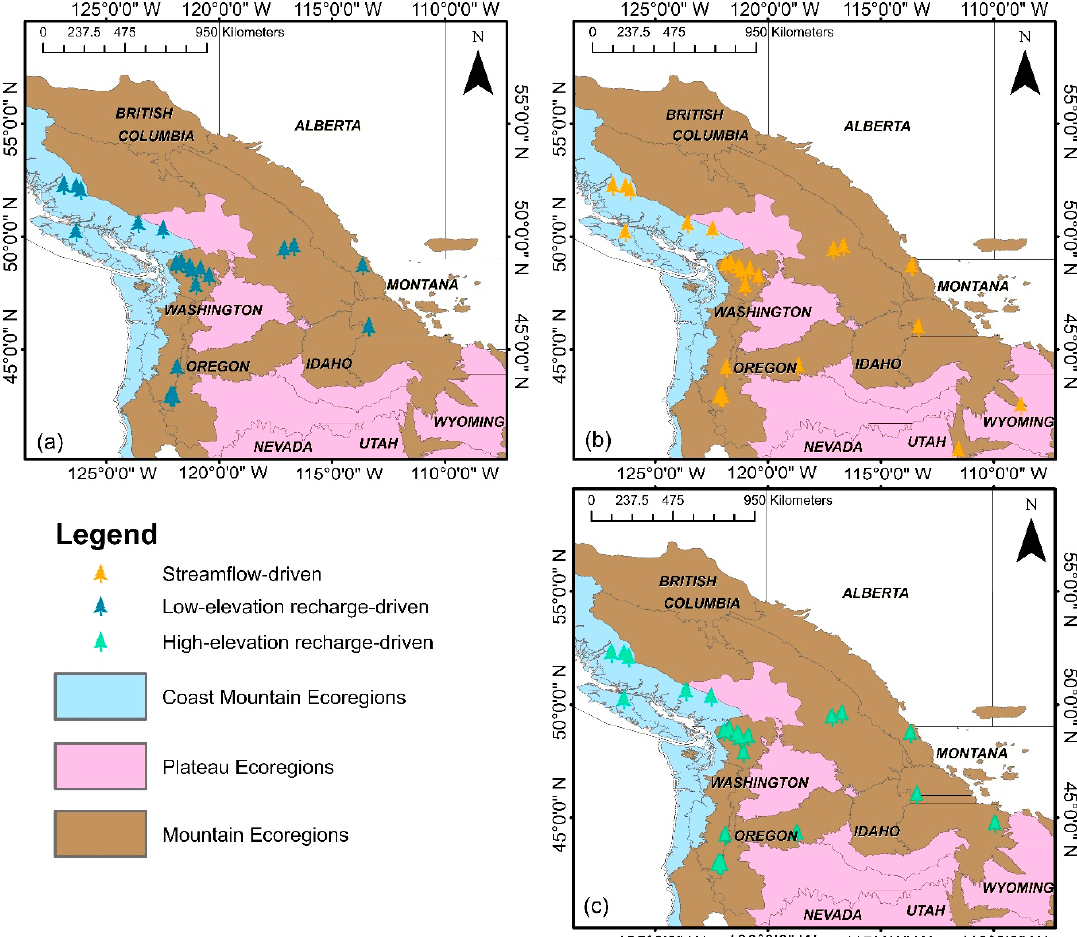
Figure 5. Tree ring records used in the ( a ) low-elevation recharge-driven, ( b ) streamflow-driven, and ( c ) high-elevation recharge-driven groundwater level models, using the climate footprint to select potential tree ring records.